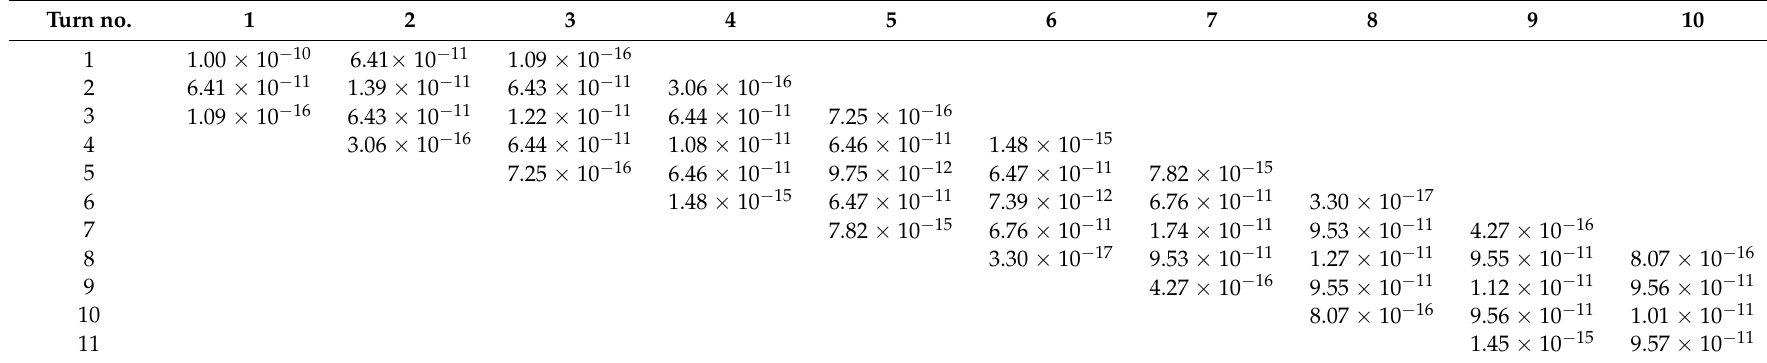
Table 3. The mutual capacitance matrix (in F) resulting from FEM simulations. Turn